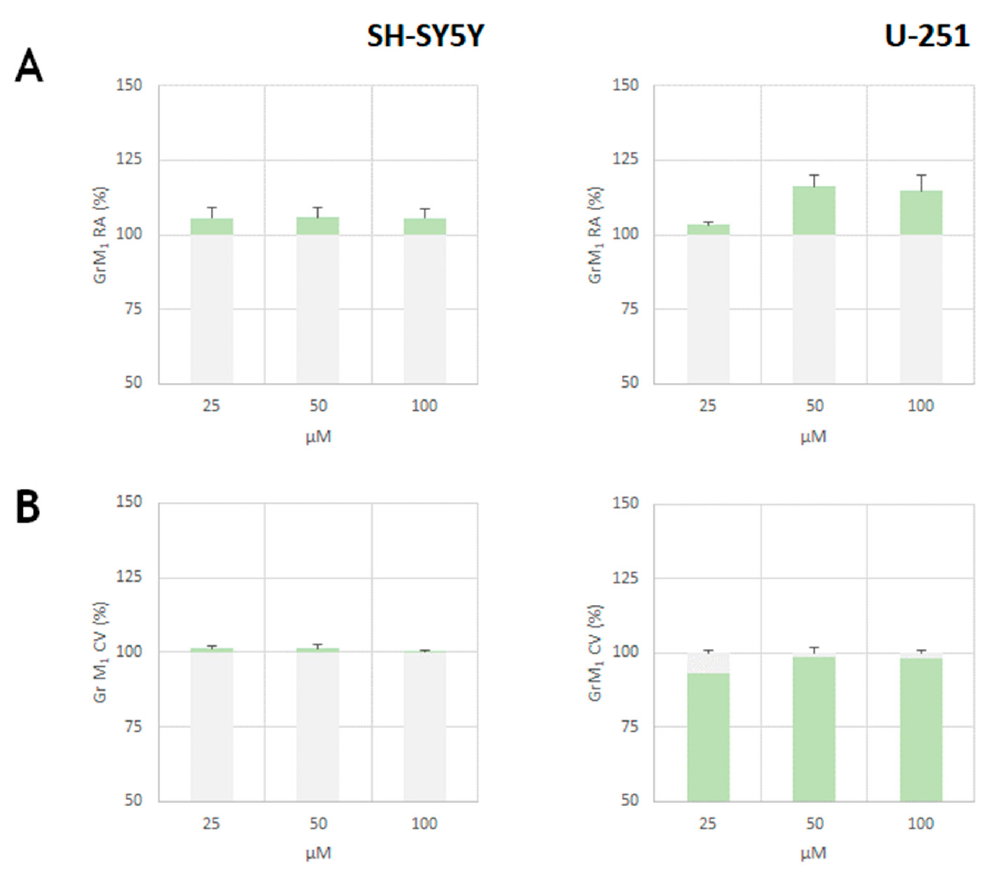
Figure 10. GrM 1 cytotoxicity on SH-SY5Y cells and U-251 MG after 48 h exposure time. Mitochondrial redox activity (RA, %) was from MTT test data ( A ), whereas cell viability (CV, %) was from sulforhodamine B (SRB) test ( B ). Values are reported as mean ± SD of measurements carried out on 3 samples (n = 3) analyzed 12 times.